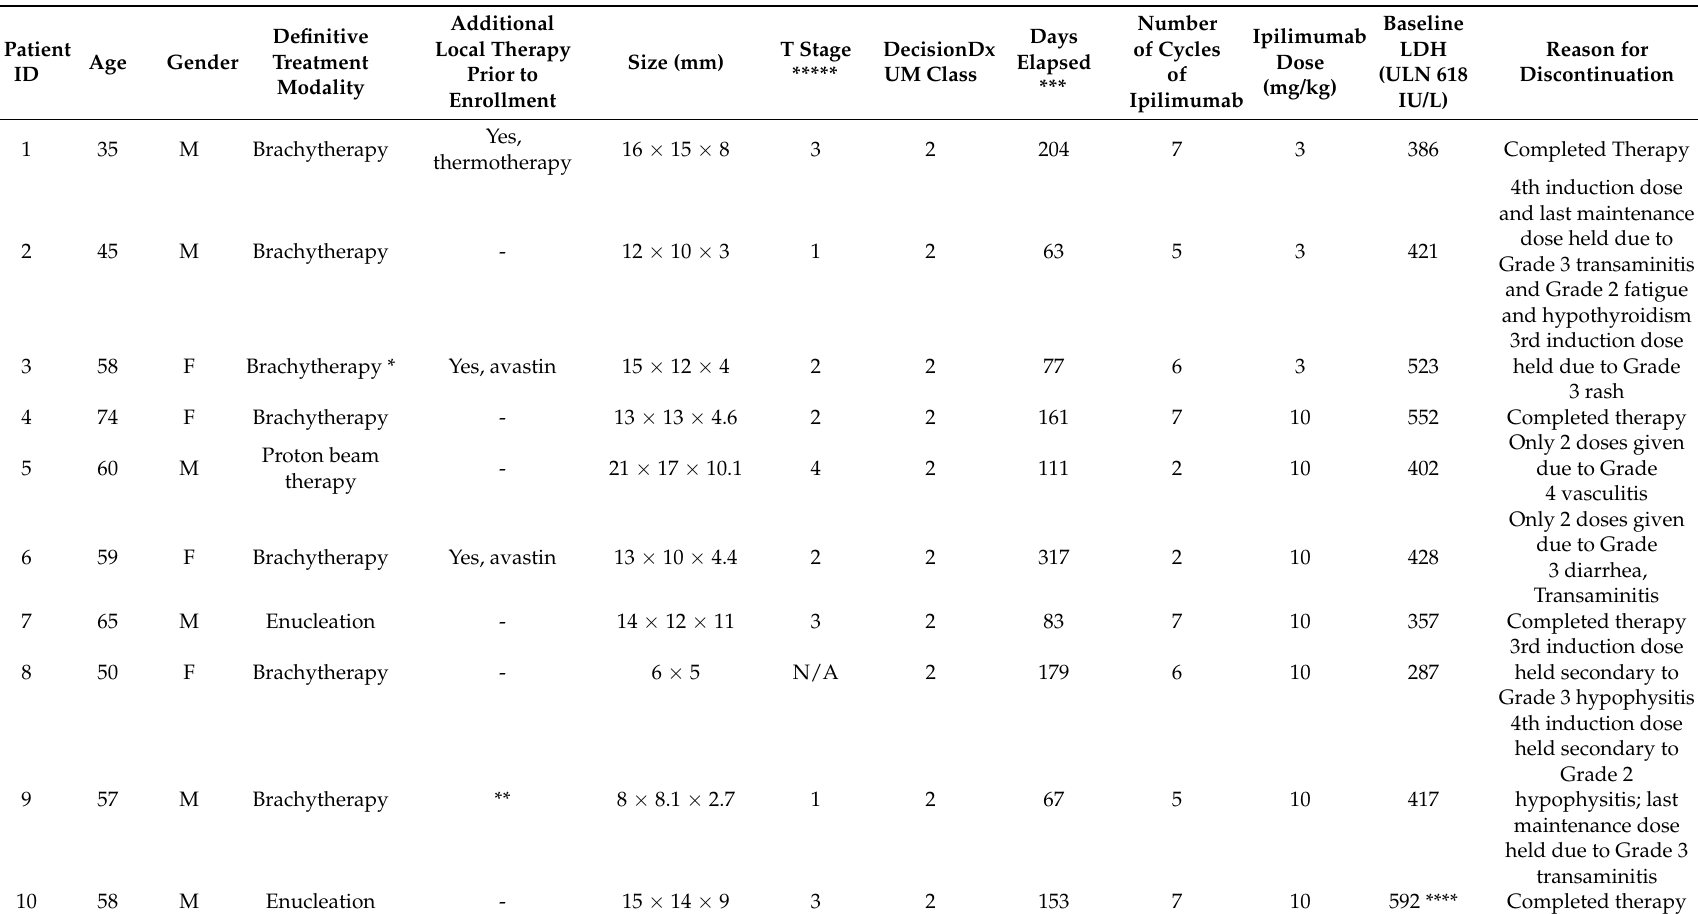
Table 1. Baseline demographics for adjuvant ipilimumab